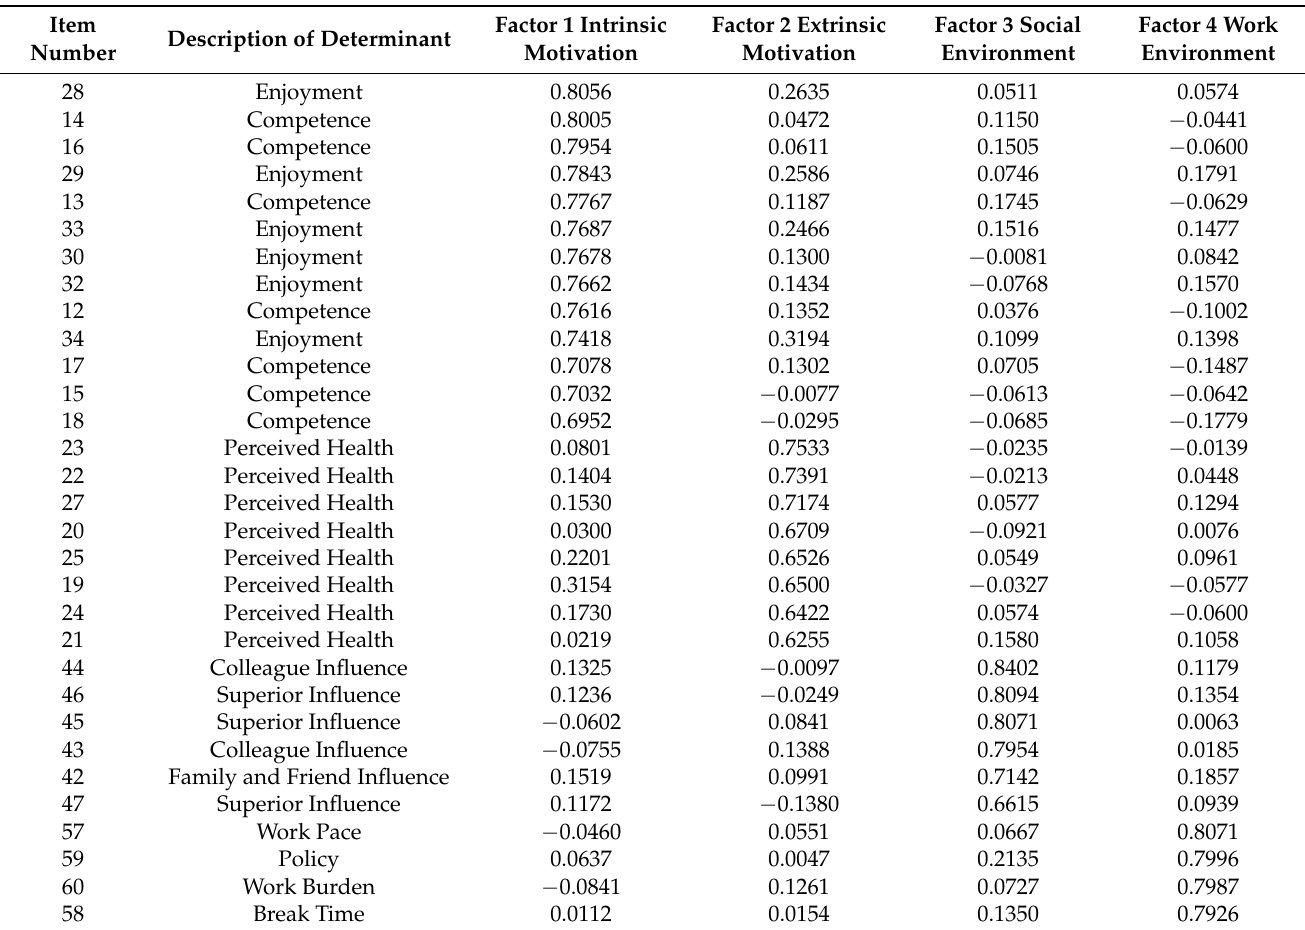
Table 3. Factor loadings of items across